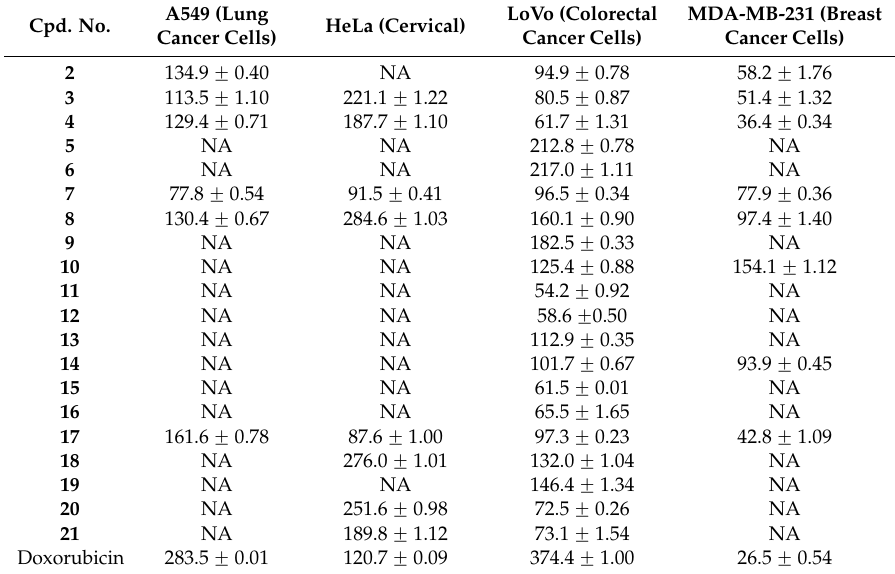
Table 1. In vitro anticancer screening of the synthesized compounds against four cell lines. Data are expressed as IC 50 ( µ M) ˘ SD ( n =